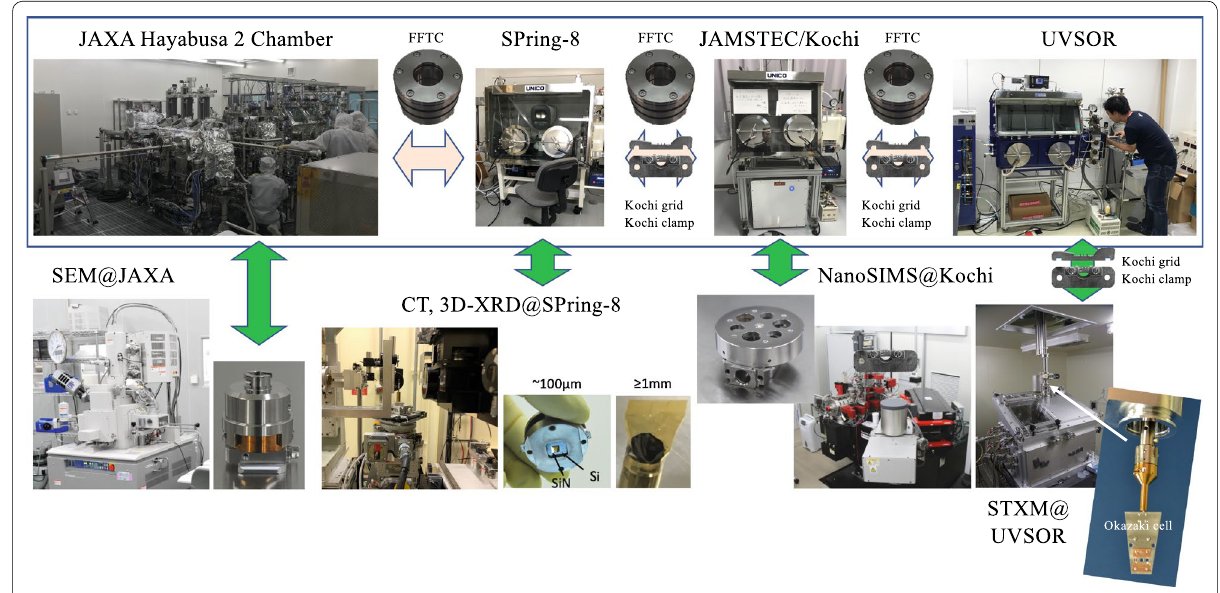
Fig. 8 Research platforms with non-air exposing systems for extraterrestrial